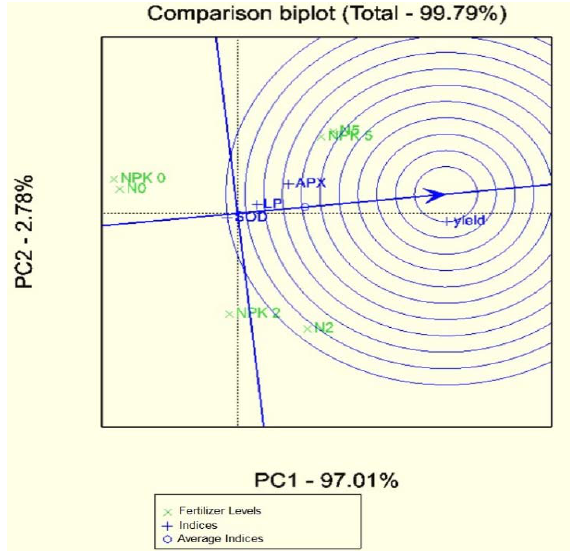
Figure 4. Biplot of indices effect to grain yield (ascorbate peroxidase (APX), lipid peroxidation (LP), superoxide dismutase (SOD)) (N = 1881). superoxide dismutase (SOD)) (N =